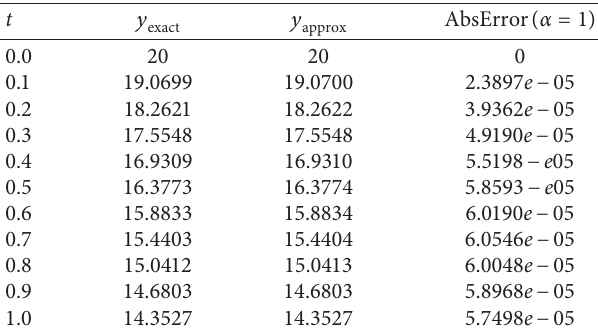
Table 5: Numerical results of Example 3 for α � 1, with mesh size h � 0 . 01.